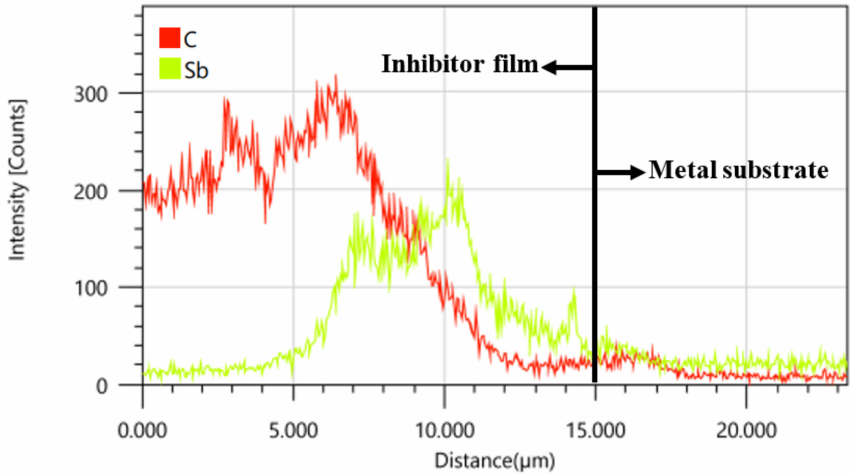
Figure 15. Line Scanning Results of Element Distribution of Corrosion Inhibitor